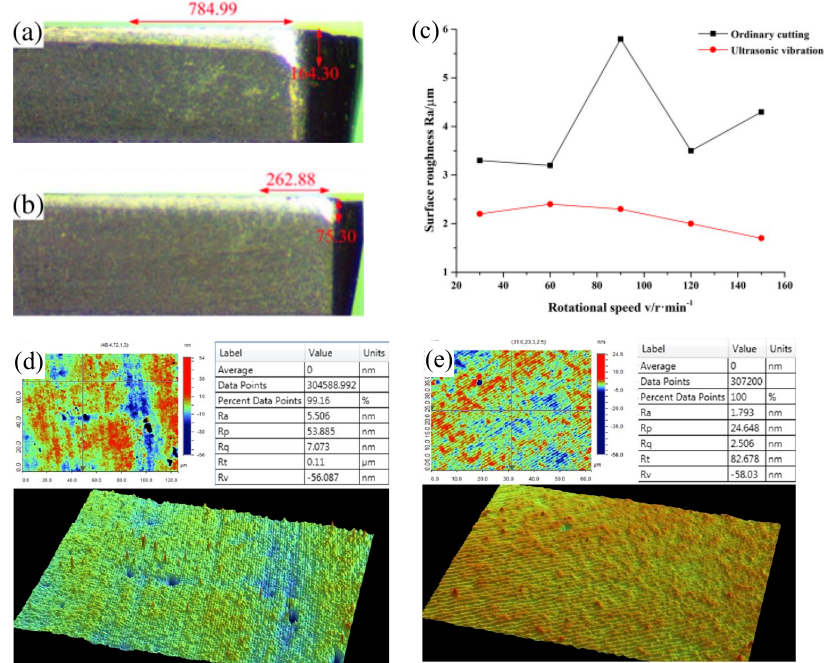
Figure 20. ( a ) Tool wear diagram under normal cutting. ( b ) Tool wear diagram under ultrasonic elliptical vibration assistance. The red mark is the main wear amount of the cutting edge. ( c ) The line graph of the surface roughness under different cutting speeds in ordinary cutting and cutting with the aid of ultrasonic elliptical vibration, adapted with permission from Ref. [127] 2016, Springer. ( d ) The edge roughness of SPDT single crystal silicon with the aid of ultrasonic vibration. ( e ) The center roughness of SPDT single crystal silicon with the aid of ultrasonic vibration [130].